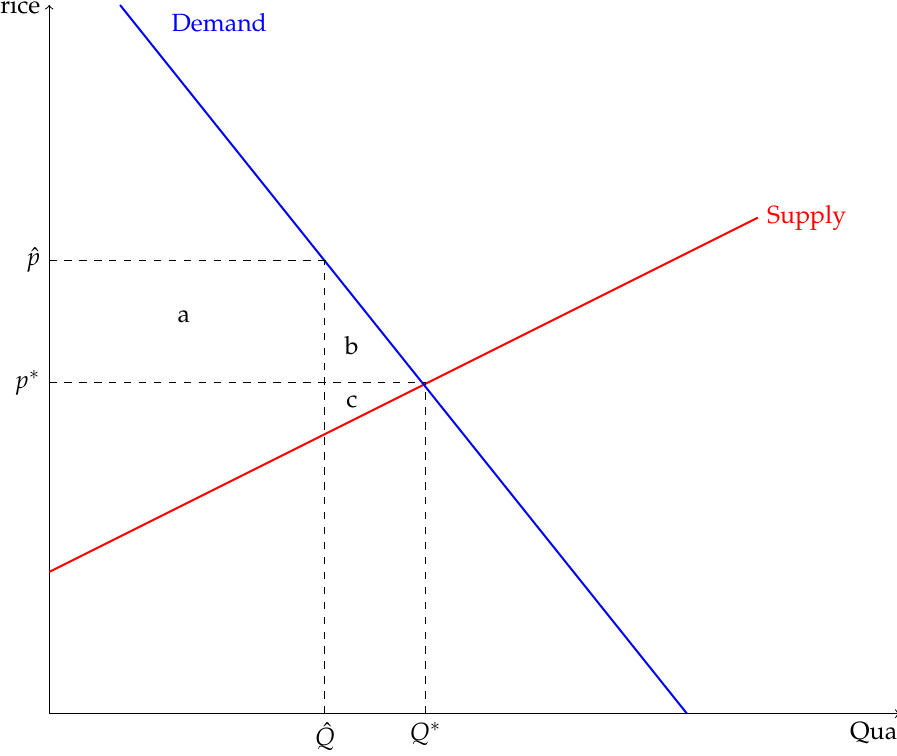
Figure 6. The Effect of the Curtailment on Prices in Alberta’s Oil Market. Area a is the transfer from consumers (refiners) to producers; area b is lost consumer surplus; area c is lost producer